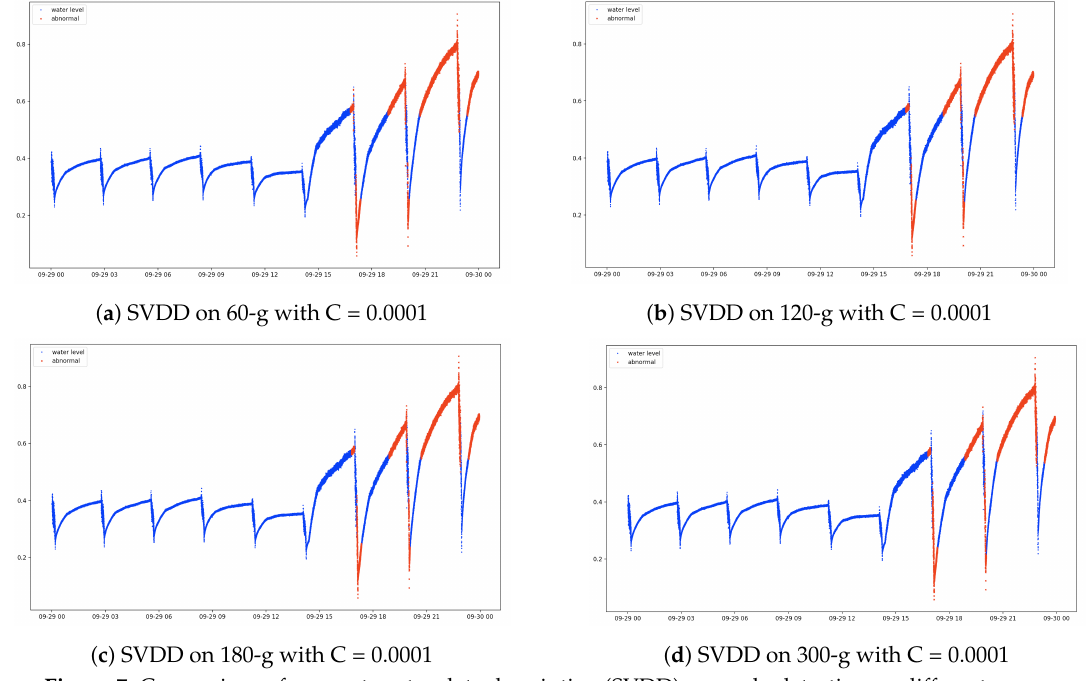
Figure 7. Comparison of support vector data description (SVDD) anomaly detection on different gram configurations